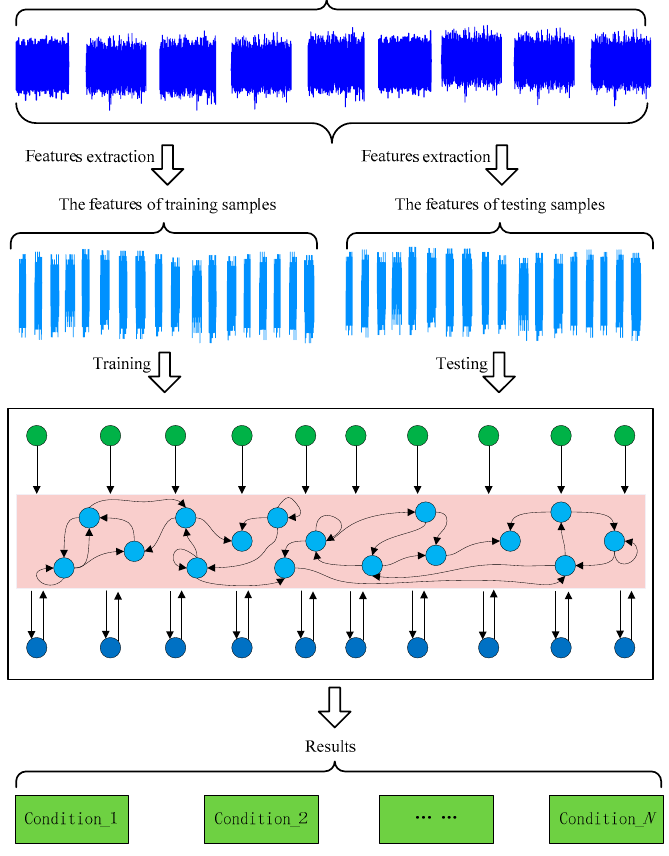
Figure 2. Schematic of transmission condition monitoring of 3D printers based on ESN.